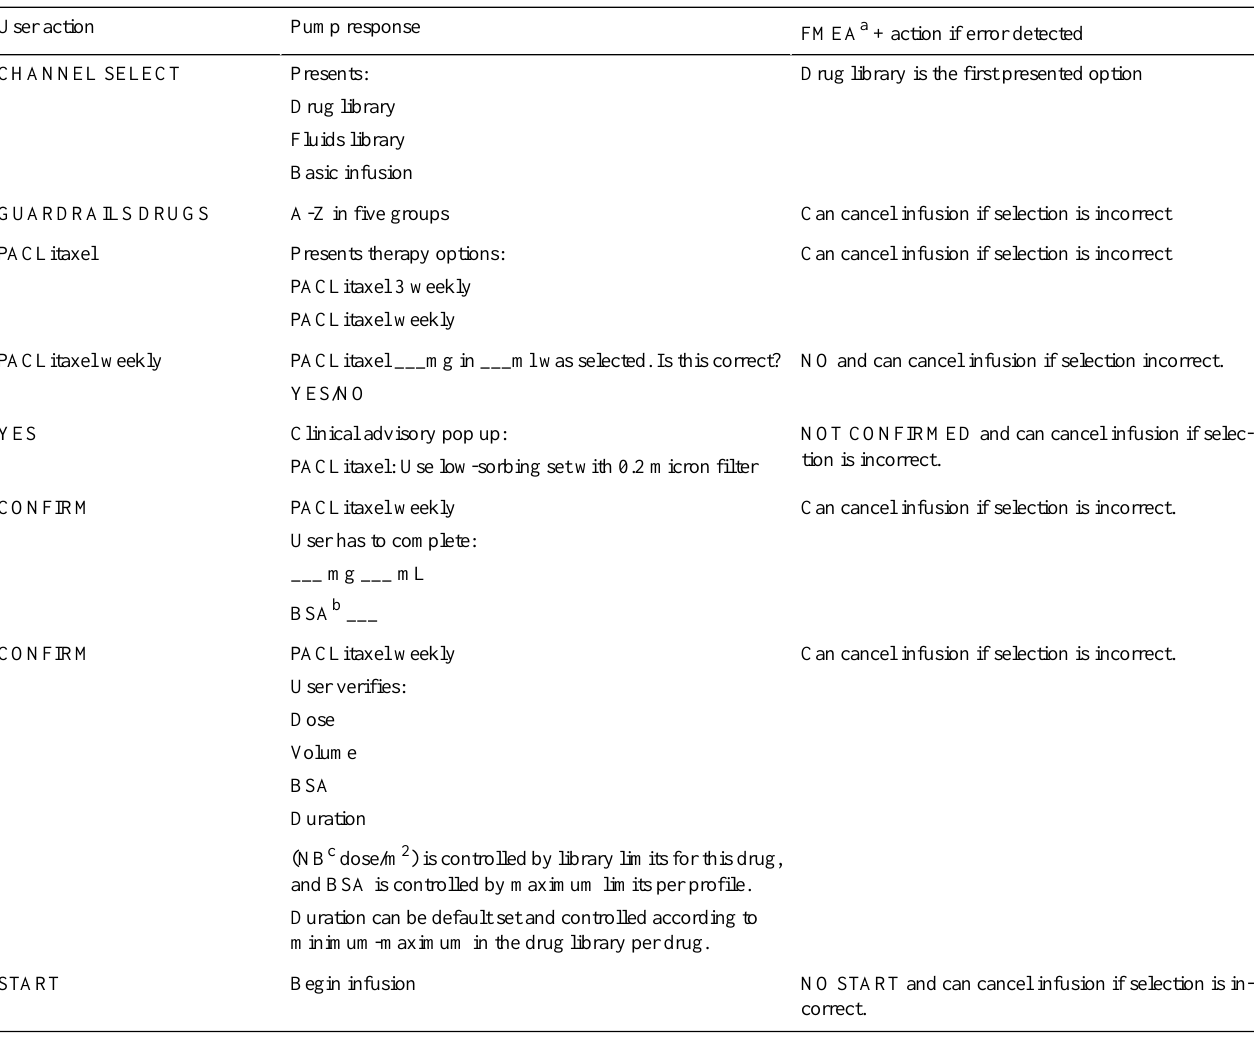
Table 8. Example of programming a drug associated with a therapy and clinical advisory using failure mode effect analysis